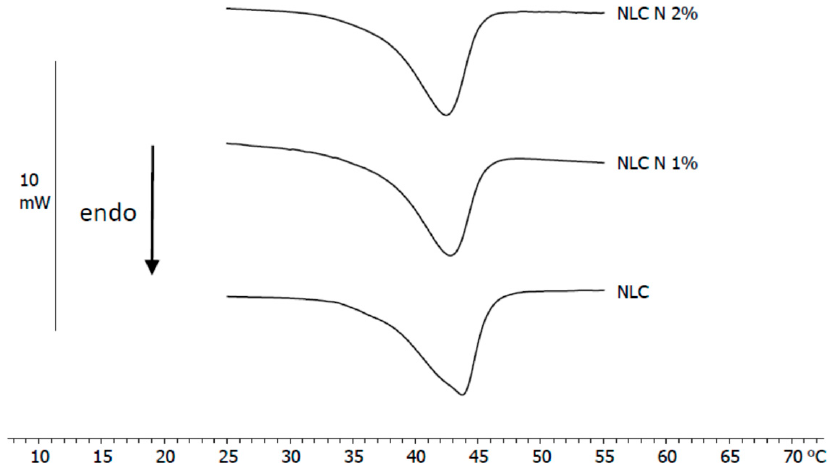
Figure 3. Calorimetric curves, in heating mode, of unloaded NLC, 1% Naringenin-loaded NLC (NLC N 1%), and 2% Naringenin-loaded NLC (NLC N 2%).